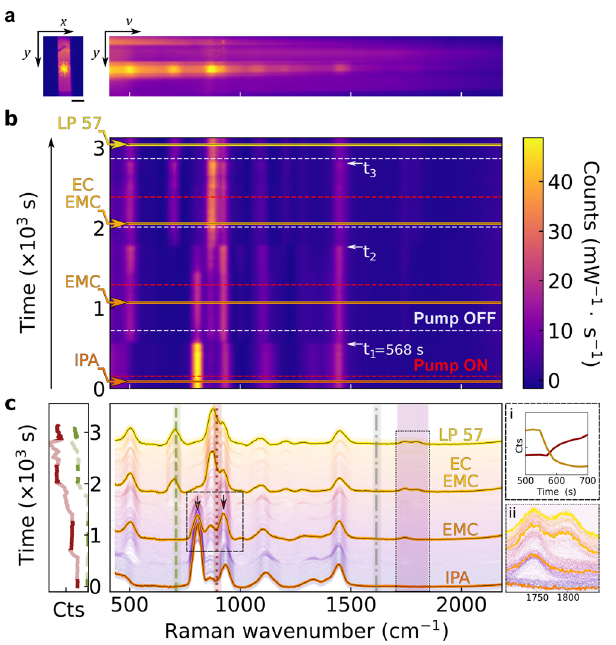
Fig. 2 Online Raman measurements in a hollow-core fi bre. a , Raman light emerging from the fi bre facet (left, image scale bar is 50 µ m) with a spectrally dispersed image (right). b , Raman spectra tracked during sequential sample in fi ltration. Red dashed lines indicate when the pump switched on; t 1 − a indicate the times at which the sample fl uid reaches the fi bre core. Dashed white lines indicate when the pump is switched off, followed by a switch of the sample syringe. Solid horizontal lines indicate times at which the spectra shown in c were taken. c , obtained spectra of the different solvent mixtures. Highlighted Raman bands relevant to battery chemistry are ethylene carbonate breathing mode at 893cm − 1 (dark red dotted line), PF 6 anion mode at 740cm − 1 (green dashed line), and vinylene carbonate -HC = CH- band centred at 1628cm − 1 (not present in these solutions and spectra). The shaded area indicates EC and EMC bands at 1700 − 1850cm − 1 relevant to lithium solvation mechanisms (see Fig. 4) Inset i demonstrates the sample exchange time as monitored by the Raman intensity of the IPA (819cm − 1 ) and EMC skeleton ( ∼ 900cm − 1 ) modes (arrows in c ). Inset ii shows rescaled EC and EMC bands at 1700 − 1850cm − 1 .